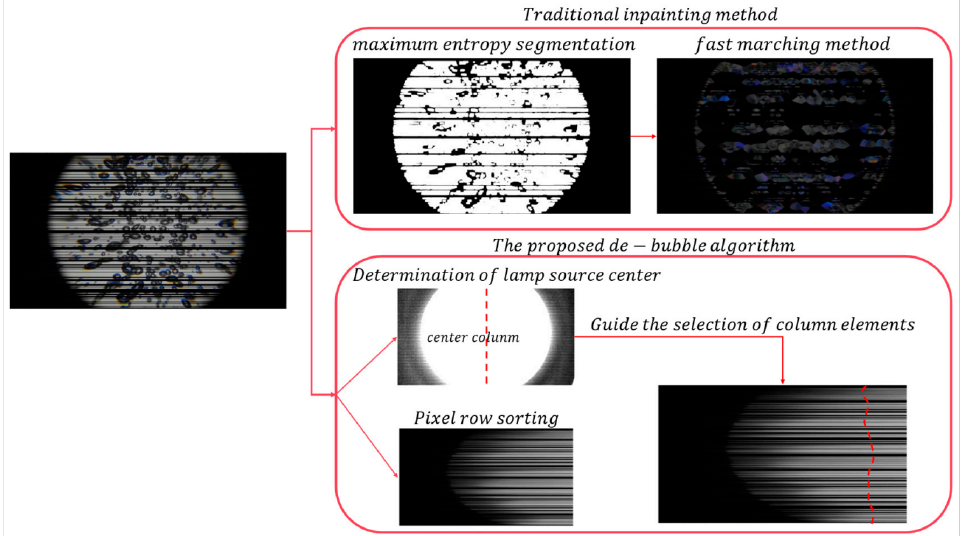
Figure 11. Comparison between fast marching method (FMM) and our proposed de-bubble